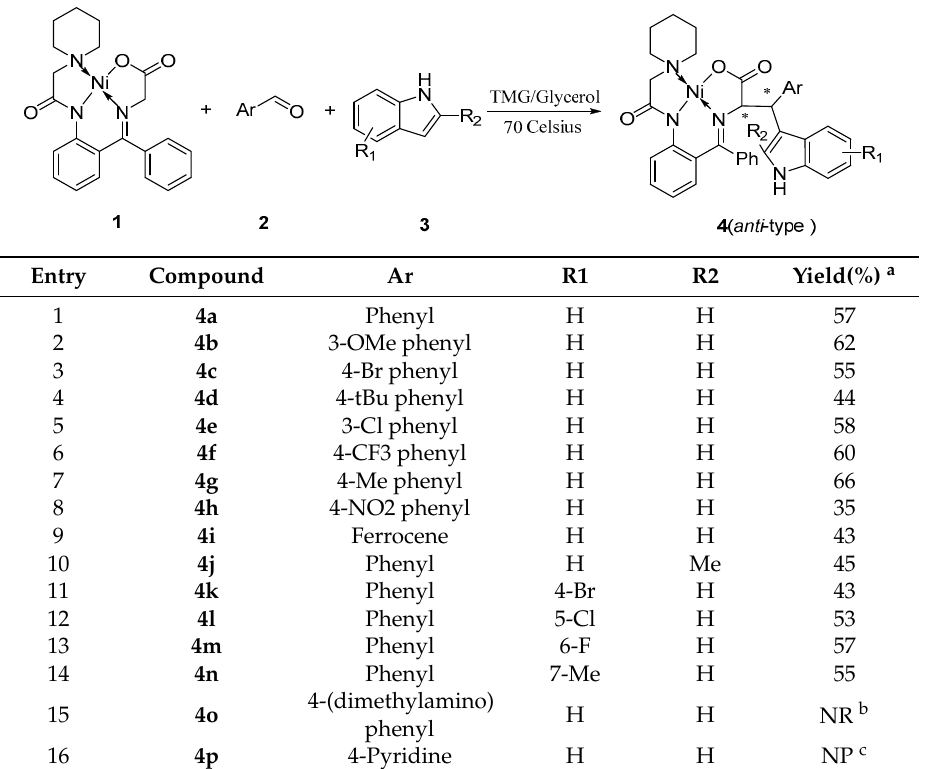
Table 2. Three-component condensation of nickel(II) glycinate, aromatic aldehydes, and indoles.